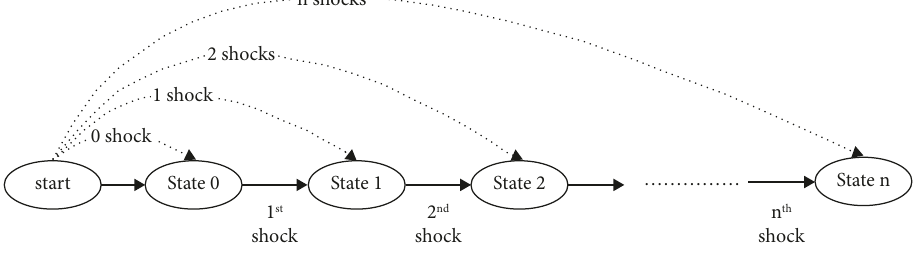
Figure 3: State transition charts of the